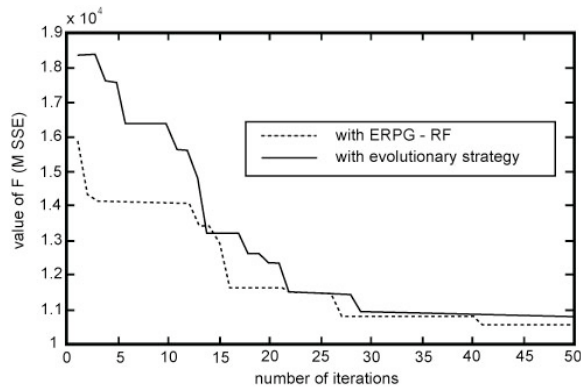
Fig. 5: Minimal value of the function at each interaction (Eq. 9)